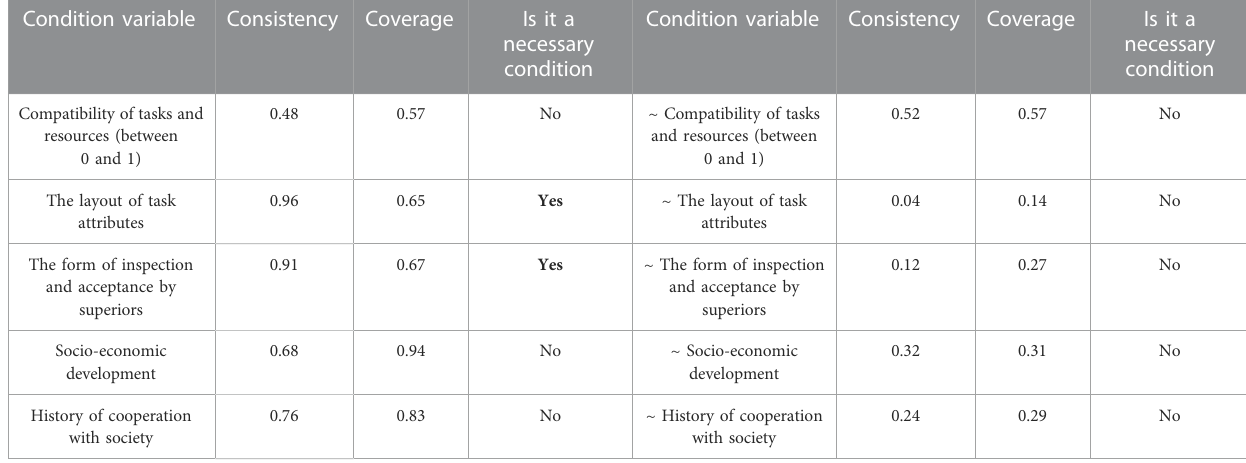
TABLE A1 Univariate Necessity Analysis with “ downward cooperation ” (cooperating with the public) as the dependent variable.